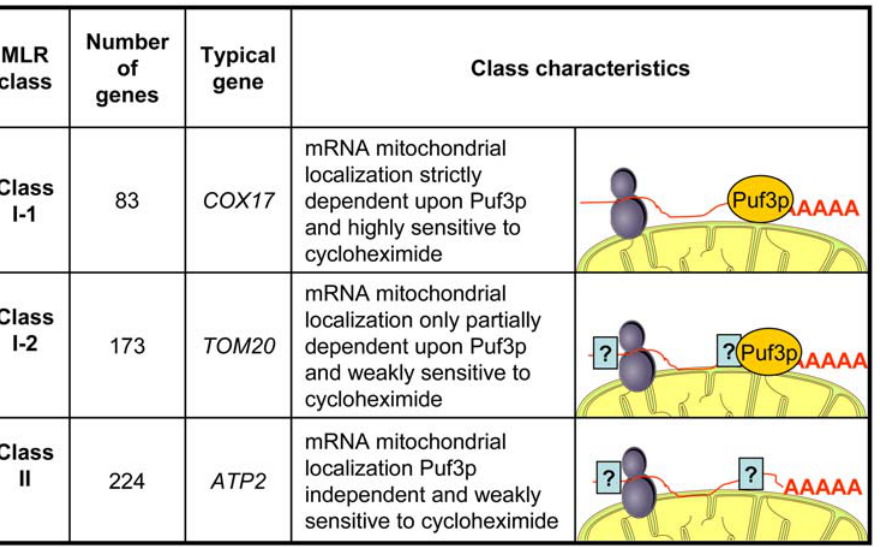
Figure 5. The 480 mRNAs localized to the vicinity of mitochondria (MLR-RNAs) can be classified according to their Puf3p- dependence. Two main classes of MLR-mRNAs can be identified: class I and class II are distinguished by the presence or absence of at least one PUF3 motif in their 3’UTR sequence respectively. In addition classI mRNAs can be, in the absence of PUF3 , totally (class I-1) or partially (class I-2) delocalized. This property seems to be correlated with the high sensitivity to cycloheximide for class I-1 mRNAs. We propose that class I-1 Puf3p target mRNAs requires mainly Puf3p for their mitochondrial localization whereas class I-2 mRNAs localization also depends on other unknown trans- acting products. Class II mRNAs are localized to the vicinity of mitochondria under the control of unidentified trans-acting